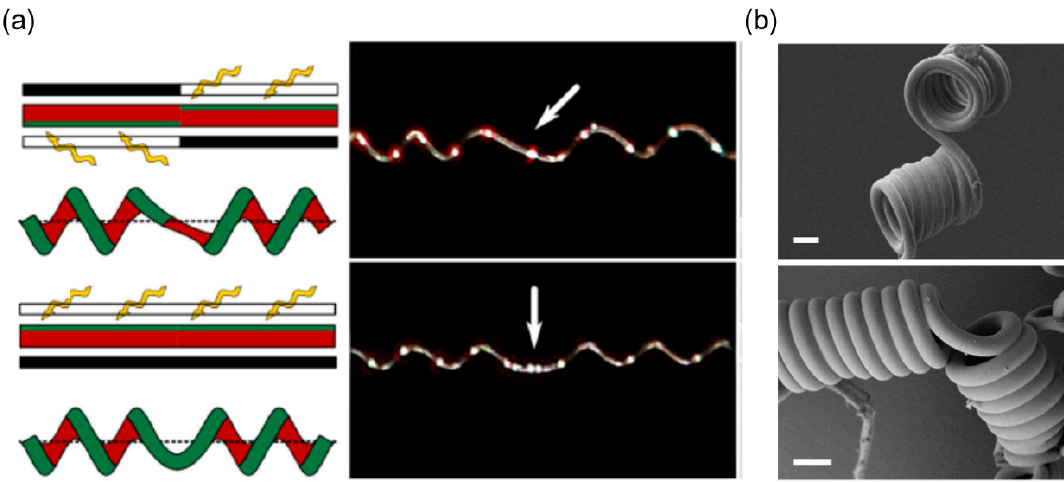
Figure 19. The asymmetry and symmetry perversion in electrospun fibers under UV irradiation. ( a ) Left: schematic illustration of asymmetry perversion (top) and symmetry perversion (bottom) guided by the UV irradiation, right: experimental figures of asymmetry (top) and symmetry perversion (bottom). The perversion is pointed out by white arrows; ( b ) SEM images of the asymmetry (top) and symmetry perversion (bottom) in electrospun fibers. The scale bar is 10 µ m. ( a , b ) are from [134], reprinted with permission from Nature Publishing Group.